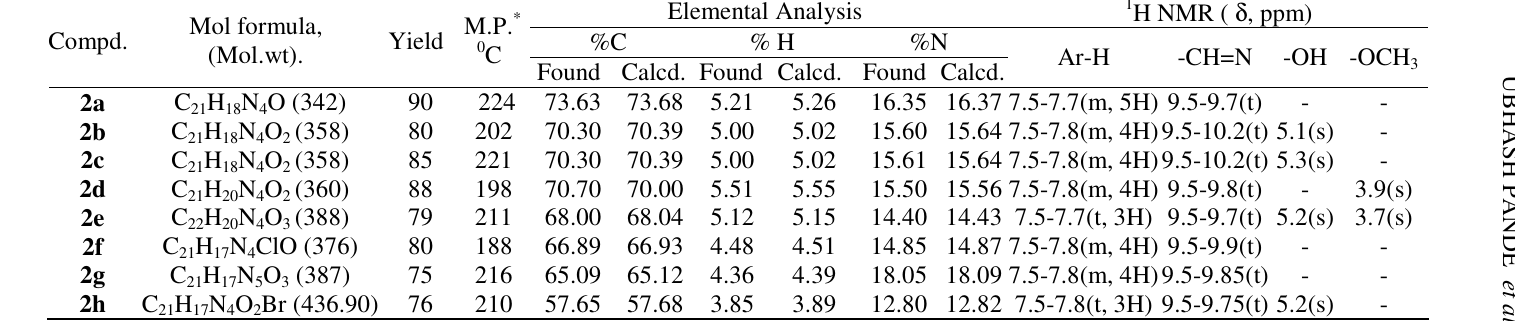
Table 1. Analytical and spectral data of compounds ( 2a-h ).